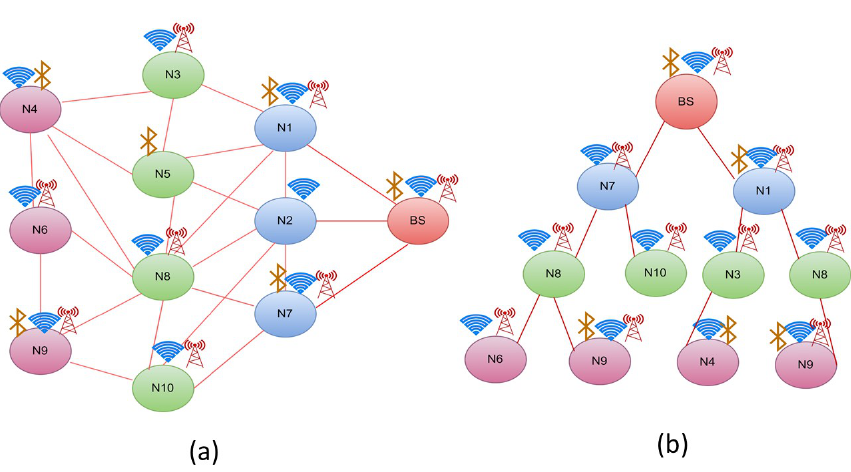
Figure 2. ( a ) Sample Network and ( b )